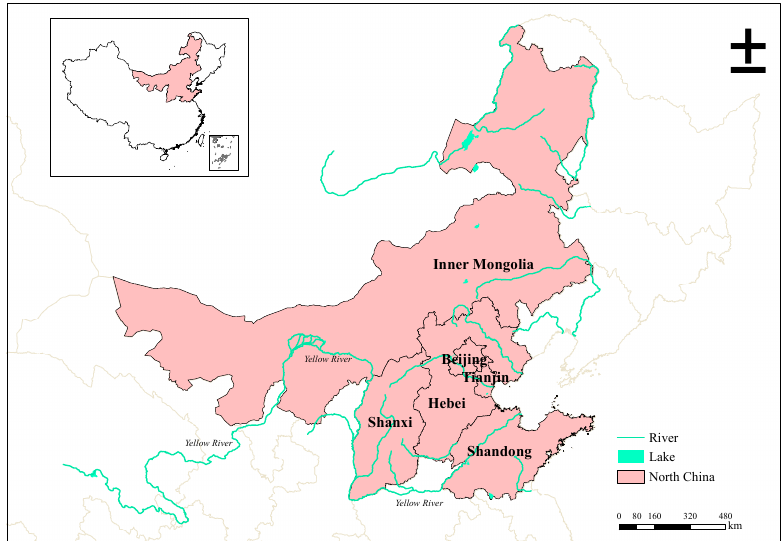
Figure 1. Location of the study area and distribution of watershed.